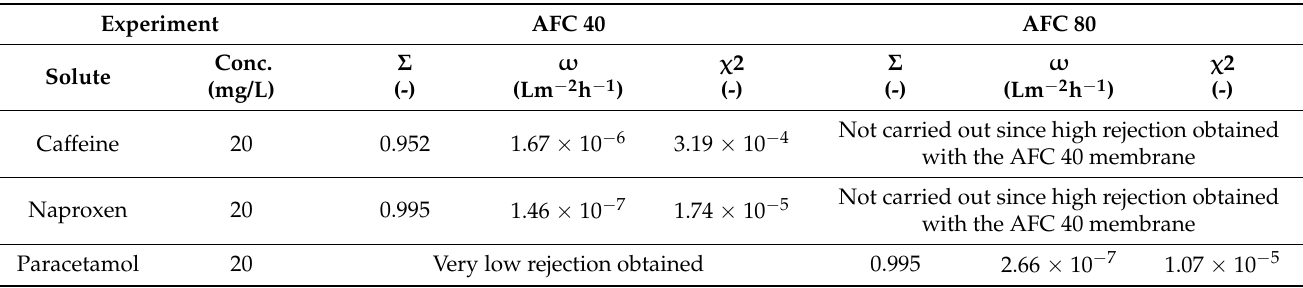
Figure 8. Spiegler–Kedem model fit for the intrinsic rejection values of ( a ) paracetamol, ( b ) caffeine and ( c ) naproxen. Table 5. Model parameters ( σ , ω ) and errors ( χ 2 ) of Spiegler–Kedem model for experiments with caffeine, naproxen and